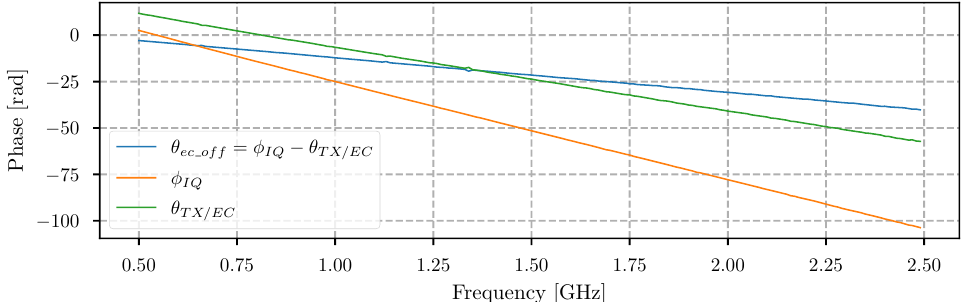
Figure 6. Unwrapped phase offset of the EC synthesizer path φ ec _ of f estimated from φ iq and θ tx / ec